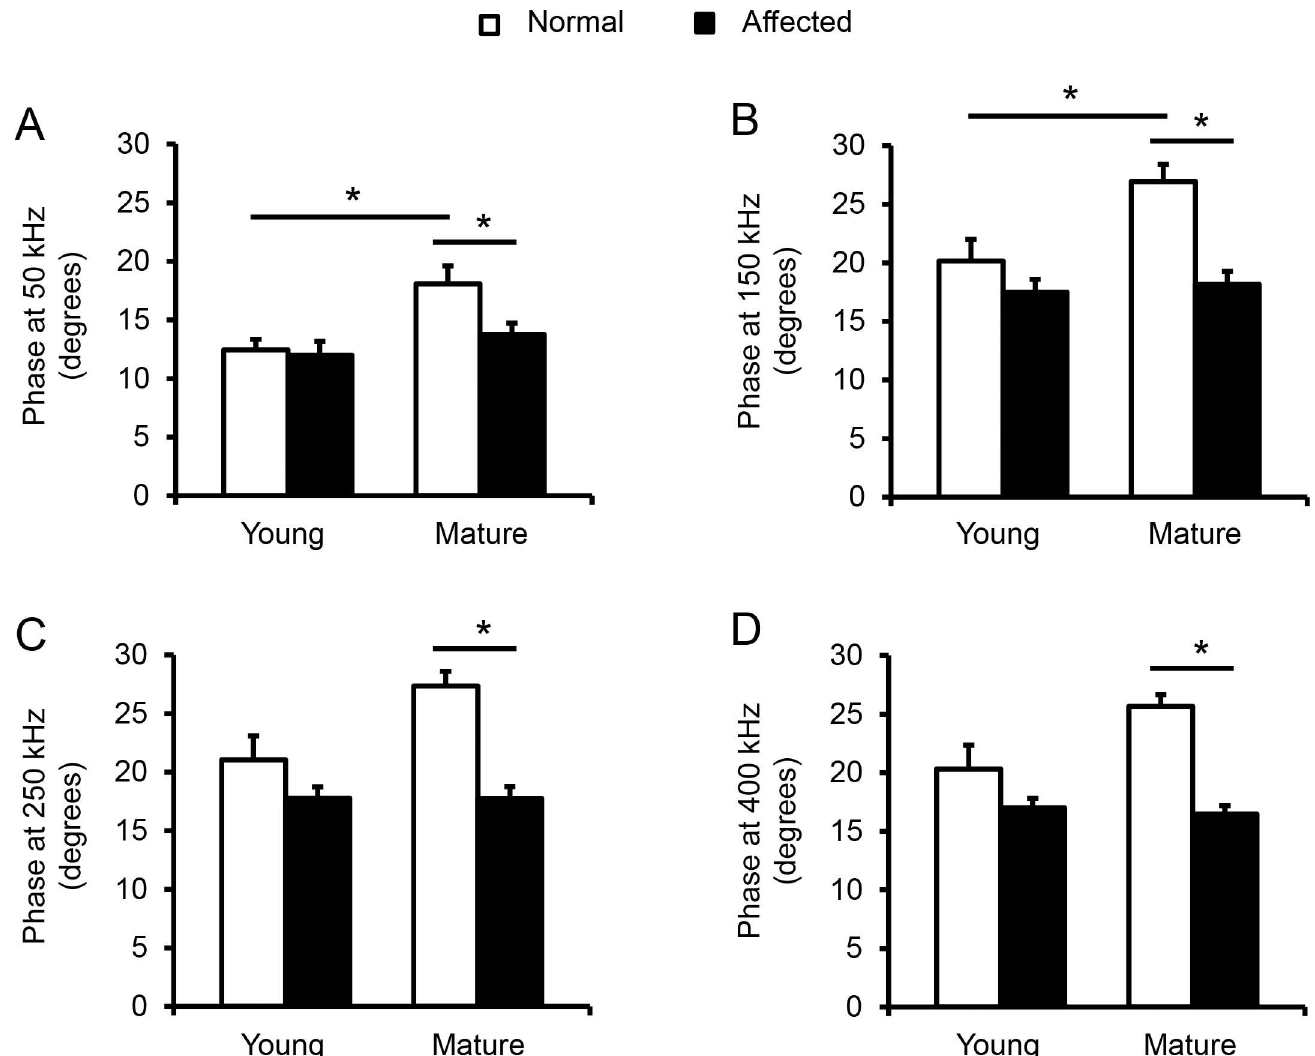
Fig 4. Multi-group comparison of phase. (A) Phase at 50 kHz. There was statistically significantdifference betweenyoung and mature normal dogs, and betweenmature normal and affected dogs. (B) Phase at 150 kHz. There was a significantdifference betweenimmature young adult and mature adult normaldogs and betweenmature normal and affected dogs. (C) Phase at 250 kHz. There was a significantdifferencebetween mature normal and affected dogs. (D) Phase at 400 kHz. There was a significantdifference betweenmature normal and affected dogs. Open bar, normal dogs; filled bar, affected dogs. The sample size for youngnormal, youngaffected, mature normal and mature affected dogs are 6, 8, 4 and 6, respectively. Asterisk, significantly different.